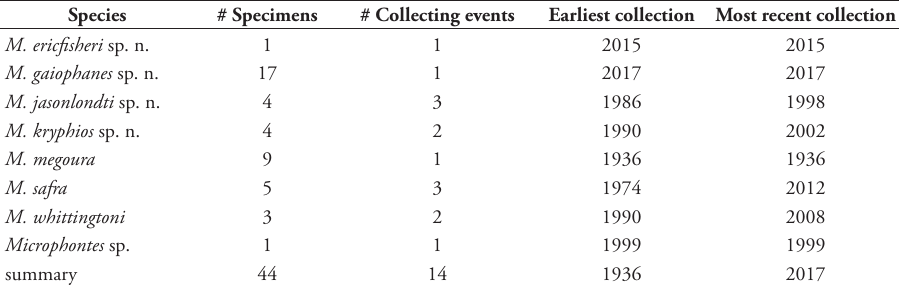
Table 1. Collecting event summary for Microphontes species. Species